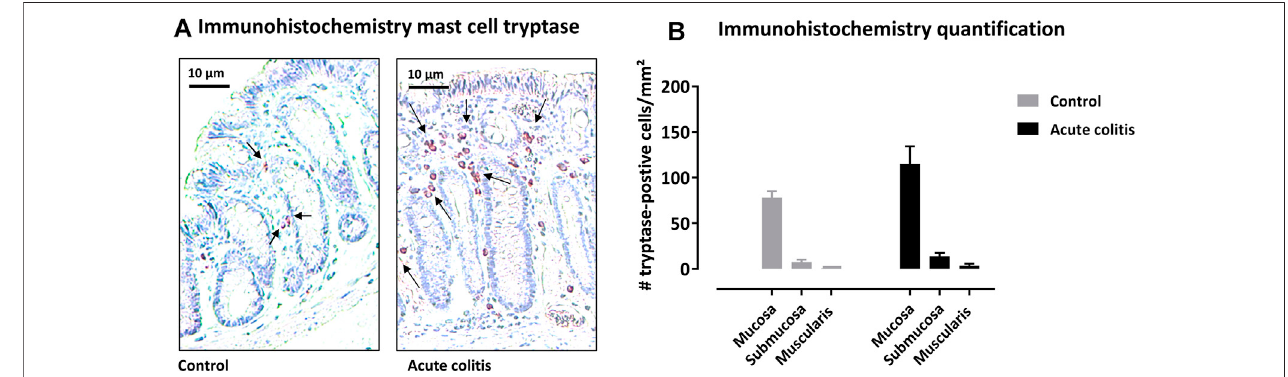
FIGURE 4 | Immunohistochemistry with mast cell tryptase antibody in rat colon. (A) Representative images of the colonic mucosa of a control and an acute colitis animal with mast cell tryptase (purple-red). (B) The number of tryptase-positive mast cells per mm2 in the mucosa, submucosa and muscularis externa in control (grey bars) and acute colitis (black bars) animals. Non-parametric testing with Kruskal-Wallis test and pairwise comparisons with Bonferroni correction for multiple